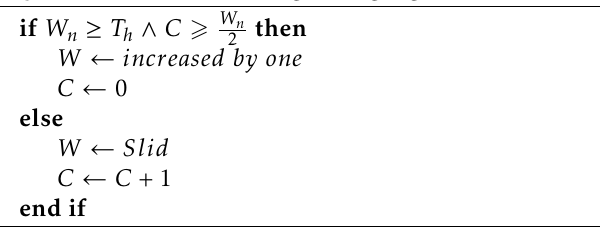
Algorithm 1 Window Size growing algorithm